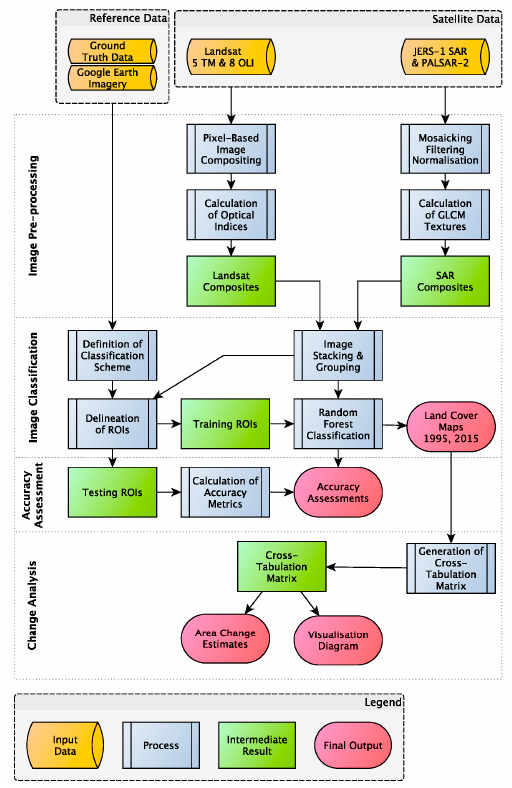
Figure 2. Overall workflow of land cover/use change mapping and analysis.